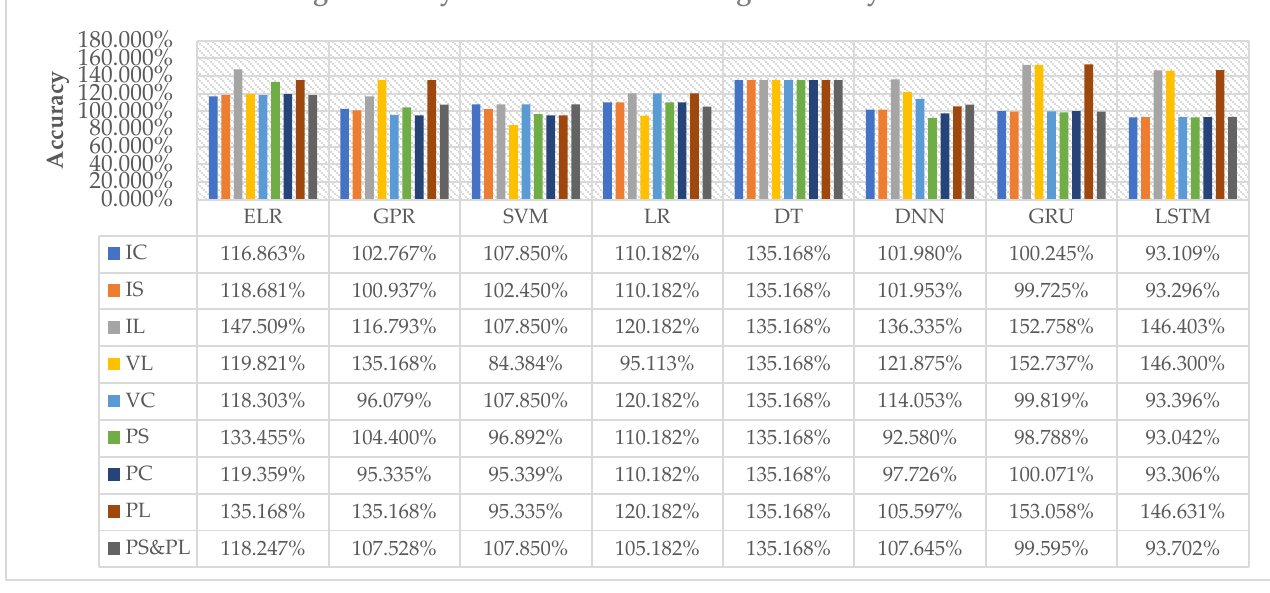
Figure 10. Average accuracy of the estimated equivalent series resistance ( ESR ) using fast Fourier transform (FFT) analysis and high-pass filter 1.